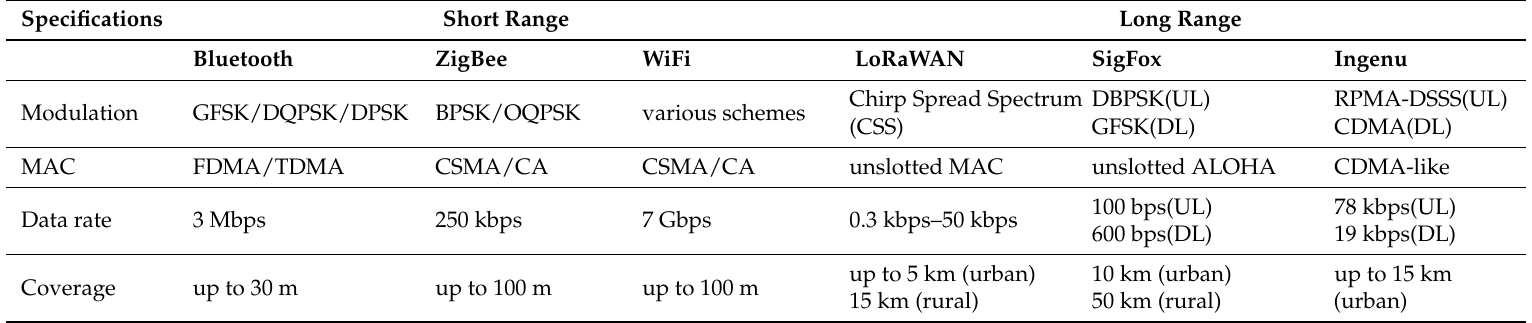
Table 1. Comparison between short-range and long-range technologies